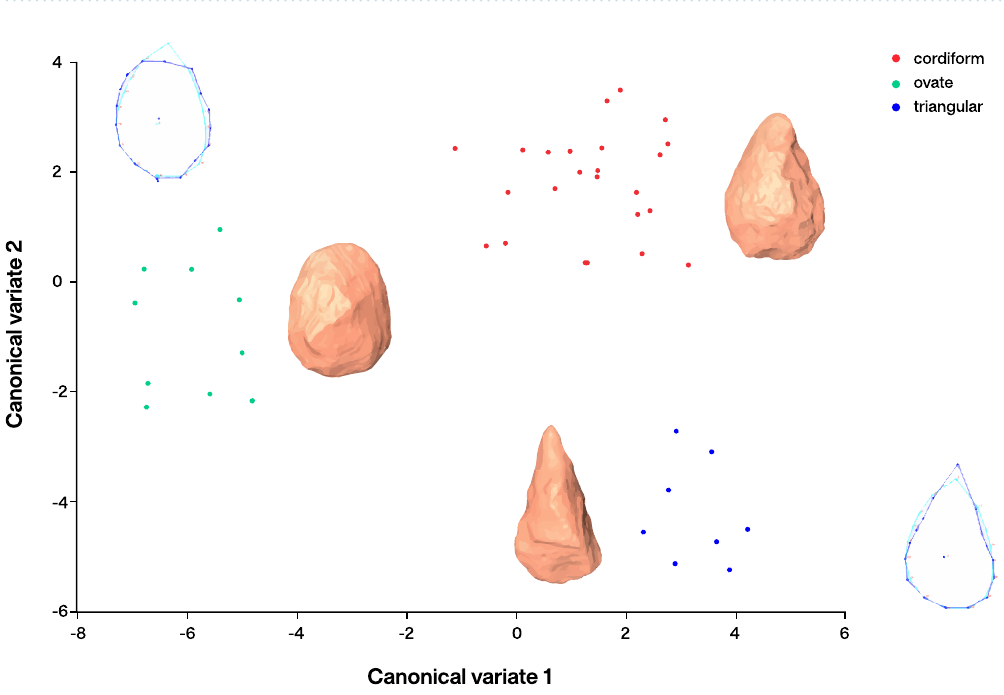
Table 1. Breakdown of artefact classes from An Nasim. Flake numbers are likely an underestimate from the site, as shifting sands hid smaller artefacts from view.